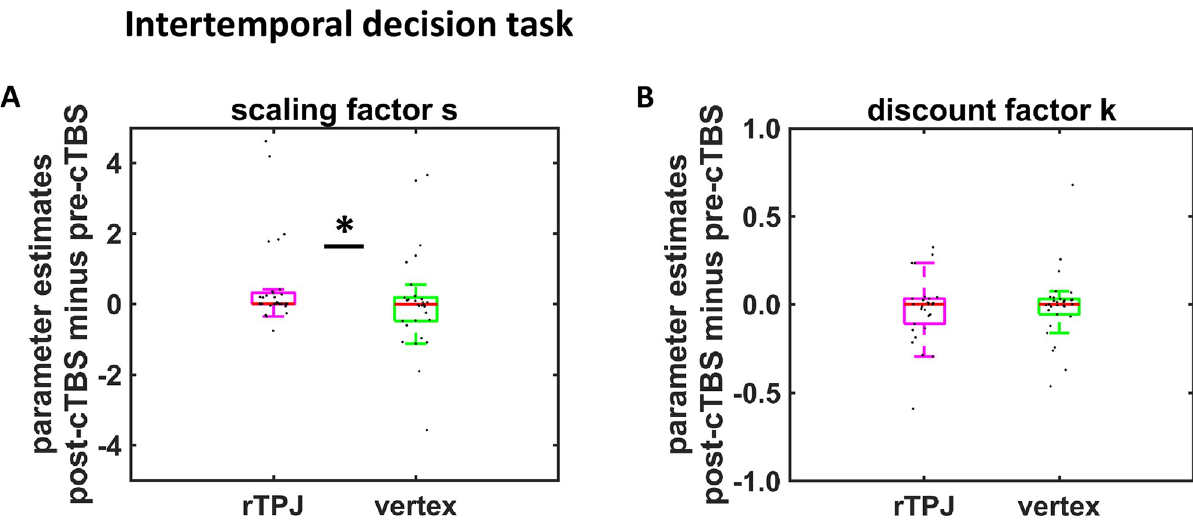
Fig 2. Effects of rTPJ cTBS on intertemporal choice. (A, B) Impact of cTBS (rTPJ versus vertex) on post-cTBS minus pre-cTBS differences in parameter estimates for (A) scaling factor s and (B) discount factor k in generalized hyperbolic discounting. Boxes indicate median (in red) and interquartile range. Black dots show individual parameter estimates. Asterisk indicates significant effect ( p < 0.05, one-tailed, nonparametric Mann- Whitney U tests. Thus, the significant difference between stimulation groups in (A) is not due to outliers). The underlying data for this Figure can be found in S1 Data. cTBS, continuous theta-burst stimulation; rTPJ, right temporoparietal junction.